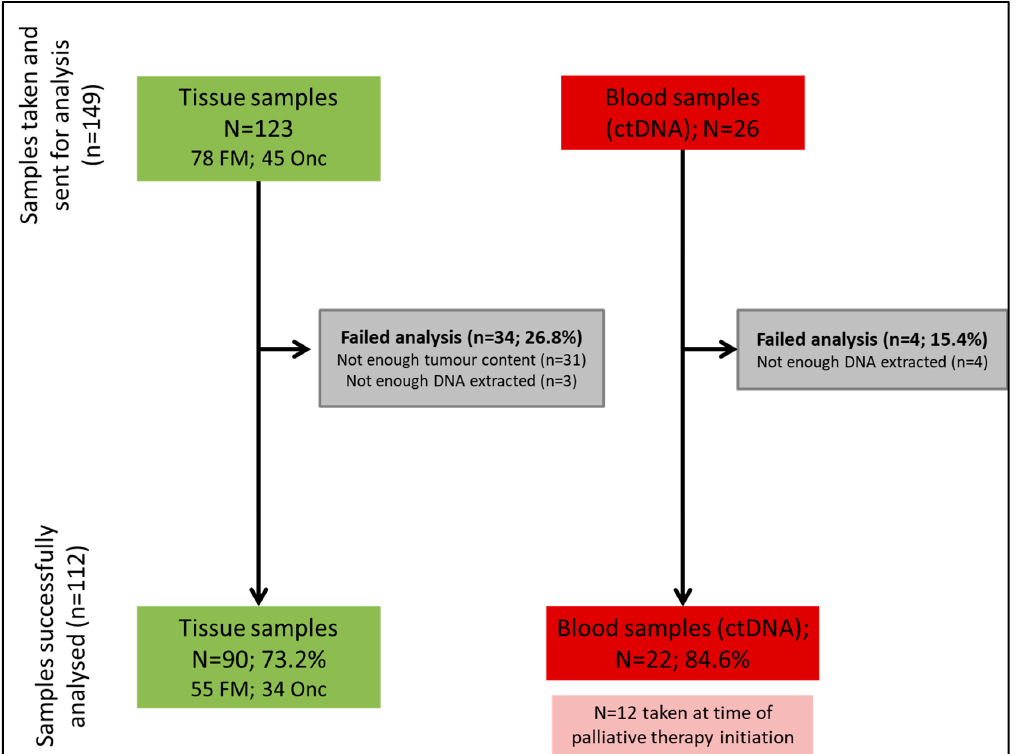
Figure 1. Sample flow. Of the total of 149 samples analysed, 26.8% of the tissue samples and 15.4% of the blood samples failed analysis. Out of the 104 individual patients included, 81 had tumour sample only analysed (no ctDNA analysis performed) (1 tumour sample analysed in 66 patients; >1 tumour